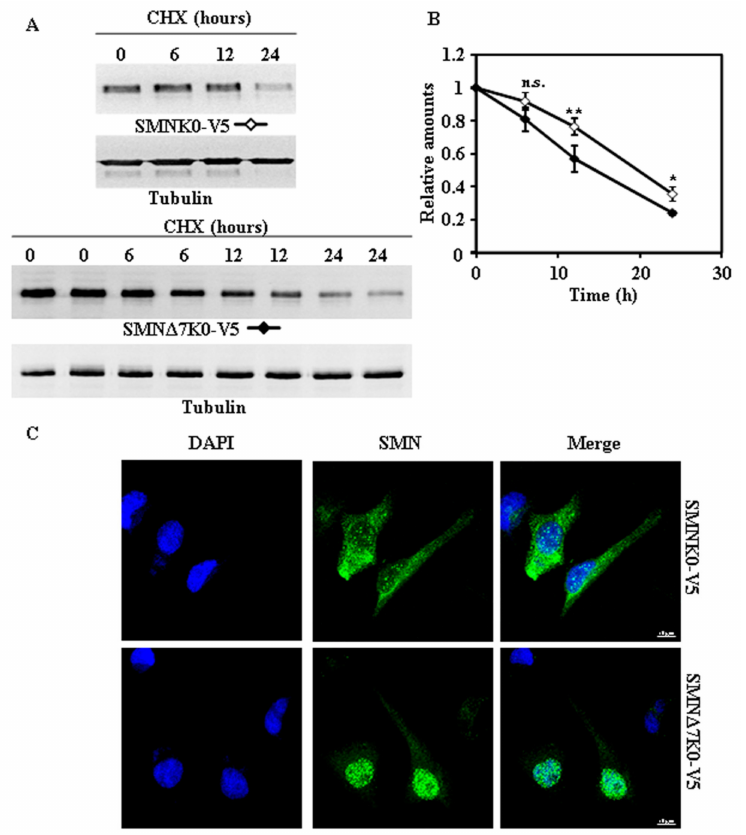
Figure 5. Degradation and subcellular localization of ectopically expressed SMNK0-V5 and SMN ∆ 7K0-V5 in HeLa cells. ( A ) HeLa cells were transiently transfected with SMNK0 or SMN ∆ 7K0 (replicates are shown for each time point) tagged at the C-terminus with V5 and treated with CHX for the indicated times. Total cell lysates were analyzed by Western and immunoblot with anti-V5 specific antibodies. Anti-tubulin antibodies were used as total protein loading control. ( B ) Graph of the quantification of the corresponding immunoblots. ( C ) Confocal fluorescence images of HeLa cells transfected with SMNK0-V5 and SMN ∆ 7K0-V5, stained with anti-V5 specific antibodies (green channel) and counterstained for nuclei with DAPI (blue channel). Bars = 10 µ m. Values are expressed as mean ± S.E.M. from at least three different experiments. Asterisks indicate a statistical significant difference between pairs (* p < 0.05, ** p < 0.01, Student’s t -test). n.s., not